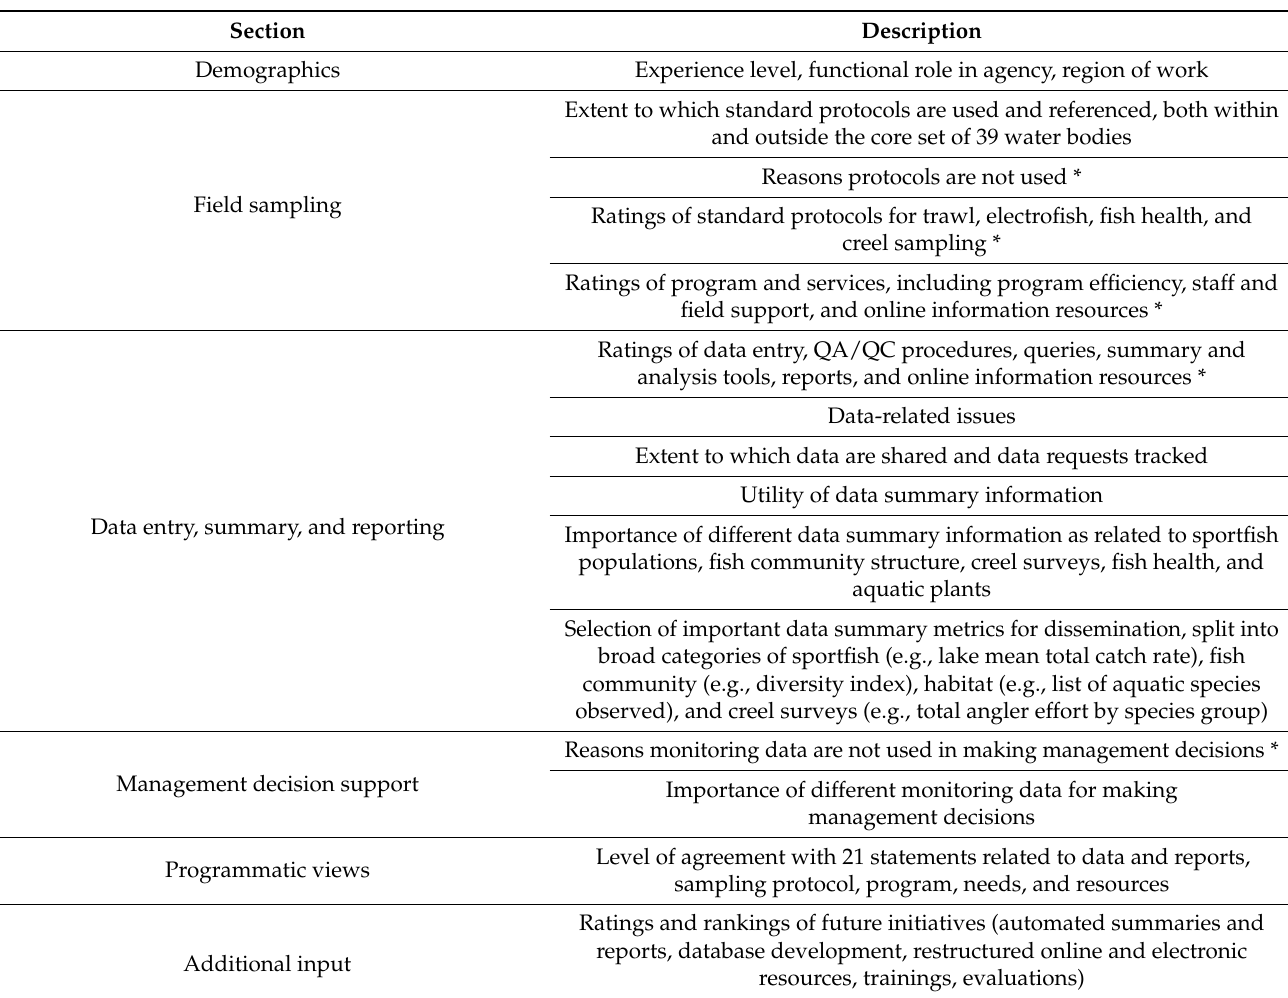
Table 1. Major components of the 15-year survey of Florida’s statewide Freshwater Fisheries Long- Term Monitoring (LTM) program. An asterisk (*) indicates a component that included at least one question that was repeated, at least in part, from a similar survey conducted at the 4-year mark of the LTM program. QA/QC = Quality Assurance/Quality